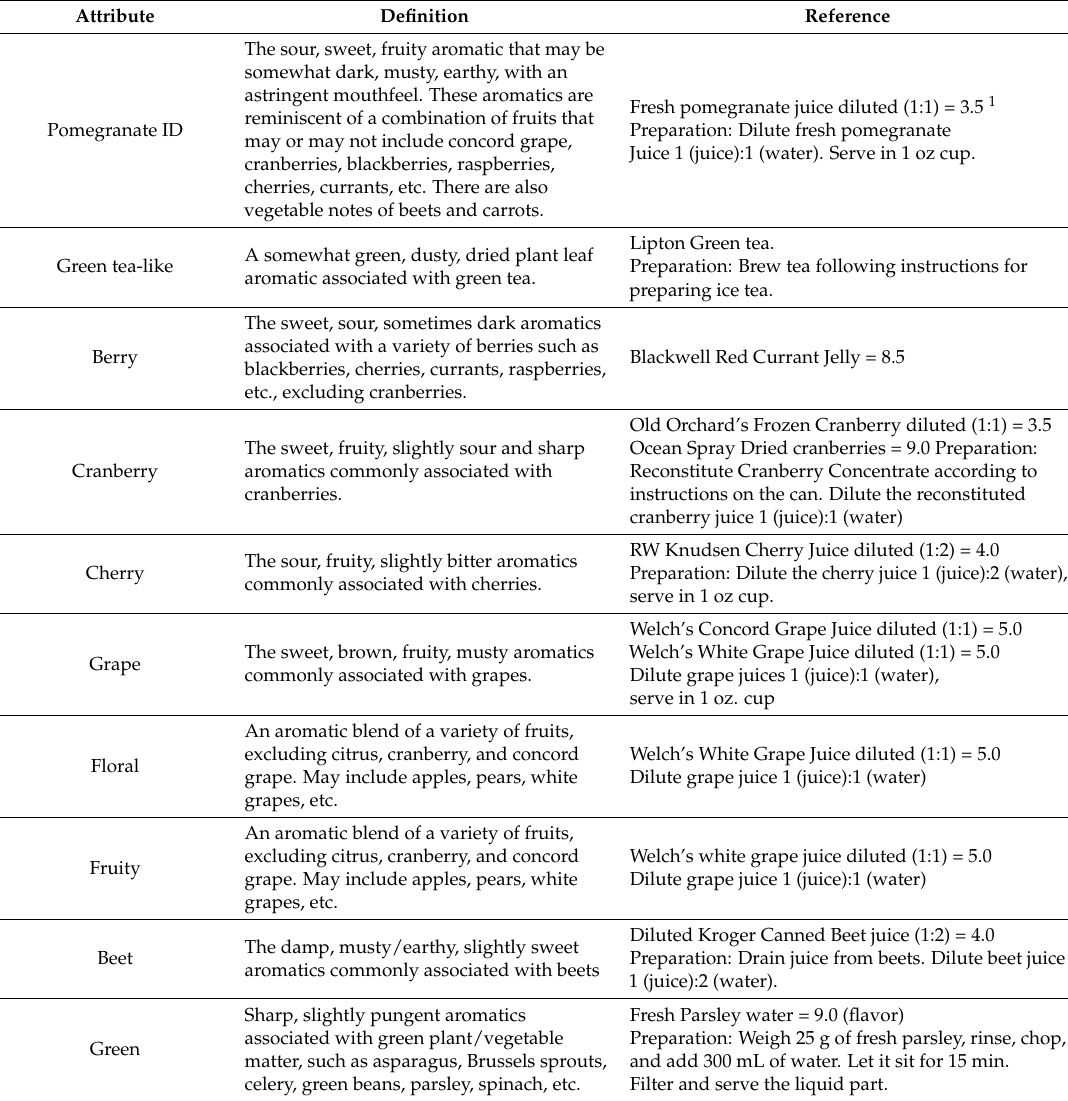
Table 1. Definition and Reference Attributes for the evaluation of the promegranate juice (PJ)–green tea (GT)